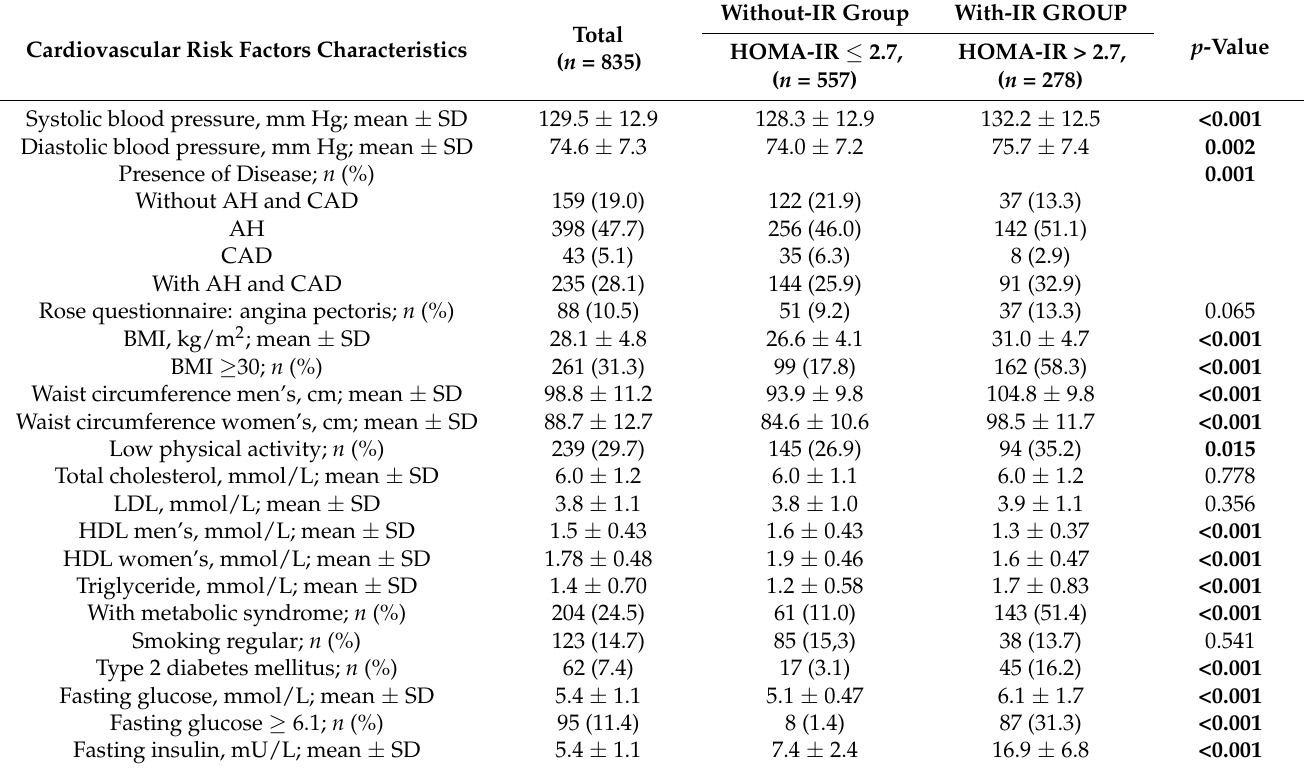
Table 3. The cardiovascular risk factor characteristics of subject groups without and with